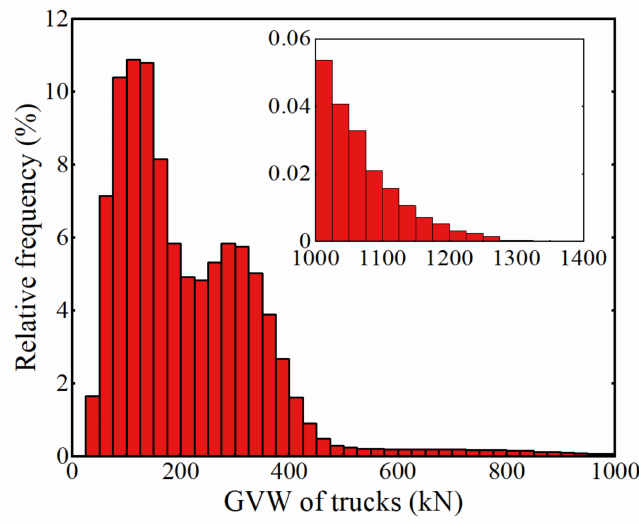
Figure 7. Distribution of GVWs of trucks in the simulated traffic